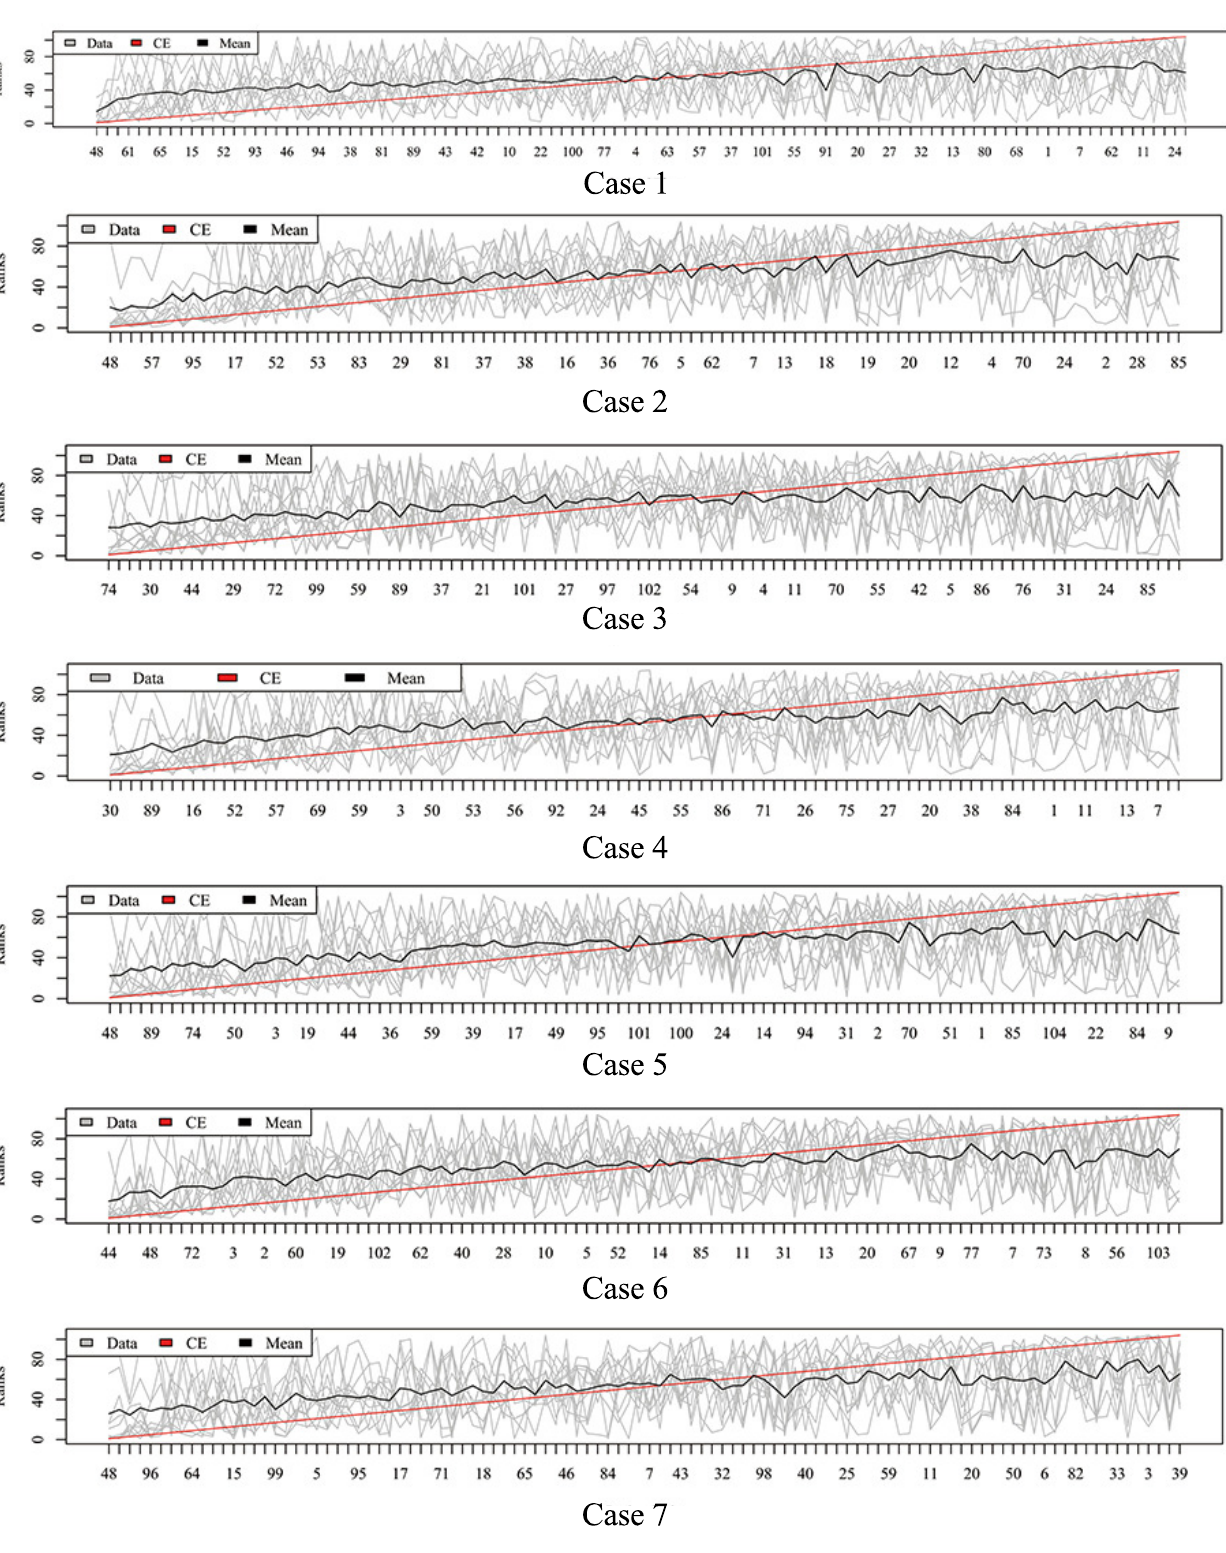
Figure 6. Rank lists of rank aggregation with the dataset “ATR” on seven